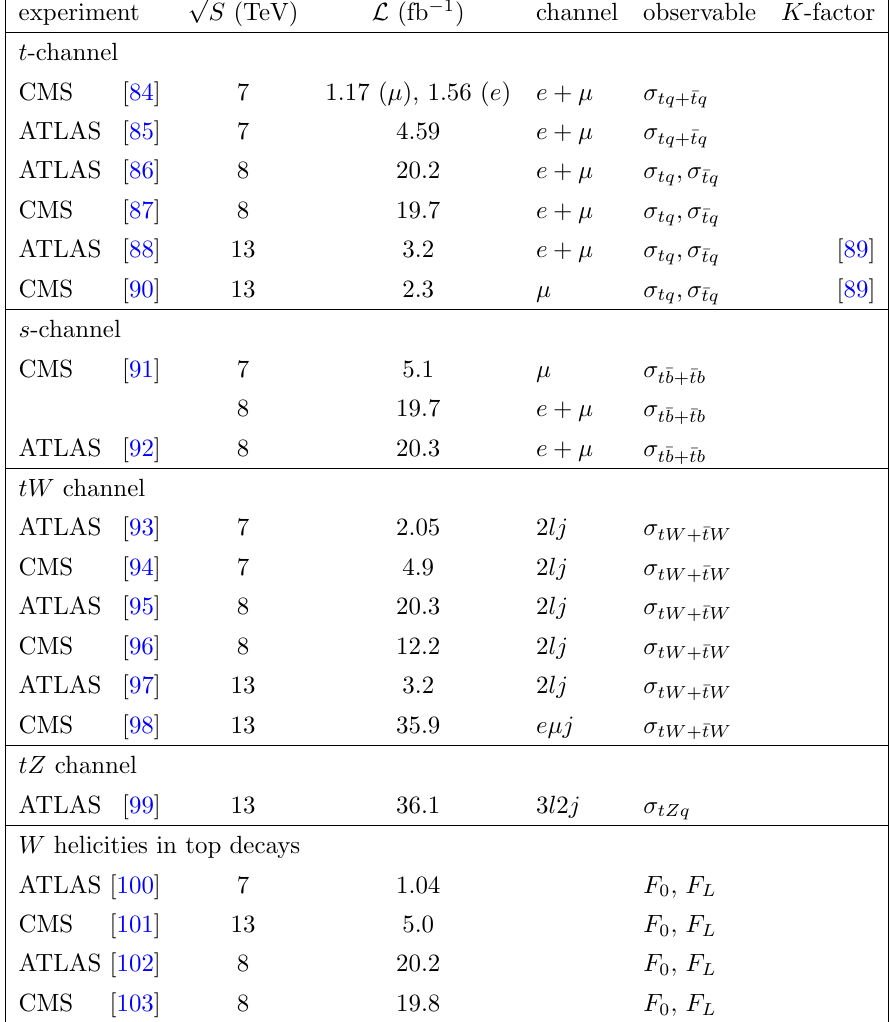
Table 6 . Observables included in the single top (cid:12)t, in analogy to table 5.